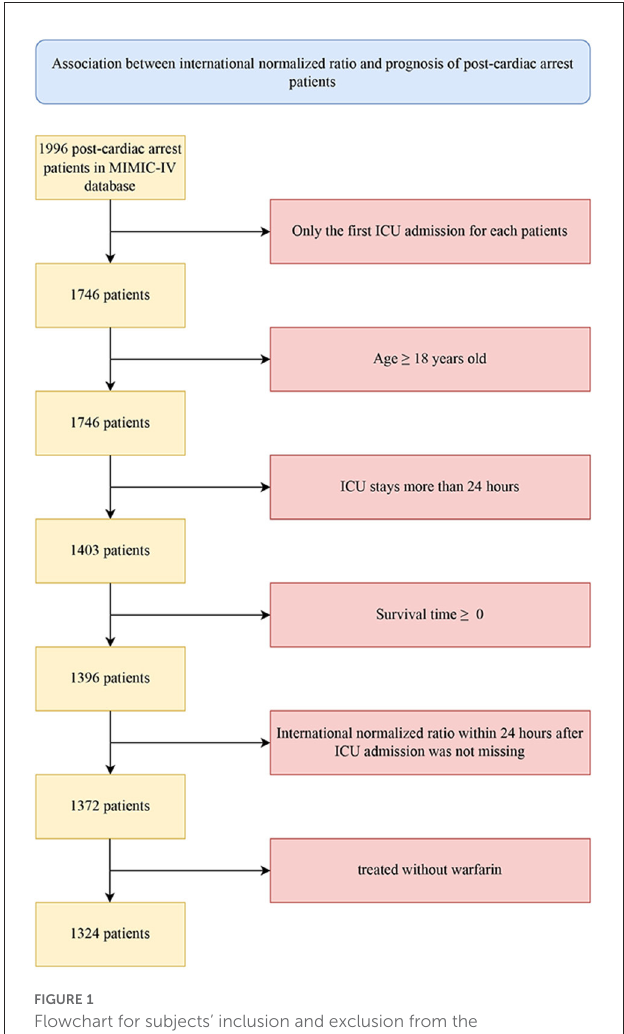
FIGURE1 Flowchart for subjects’ inclusion and exclusion from the MIMIC-IV